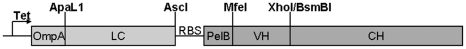
Construction of tet promoter bacterial IgG expression plasmid.pASK-IBA2 plasmid using a tet promoter was used as the backbone expression vector. The appropriate restriction sites for cloning in of the light and variable heavy chains, leader sequences (OmpA, PelB) and the constant heavy chain sequence (CH) were added. Light (LC) and variable chains (VH) were cloned in as a complete construct together with the intercistronic ribosomal binding site (RBS) from the phage display vector or as separate constructs from the 4G2 mammalian IgG expression vector.